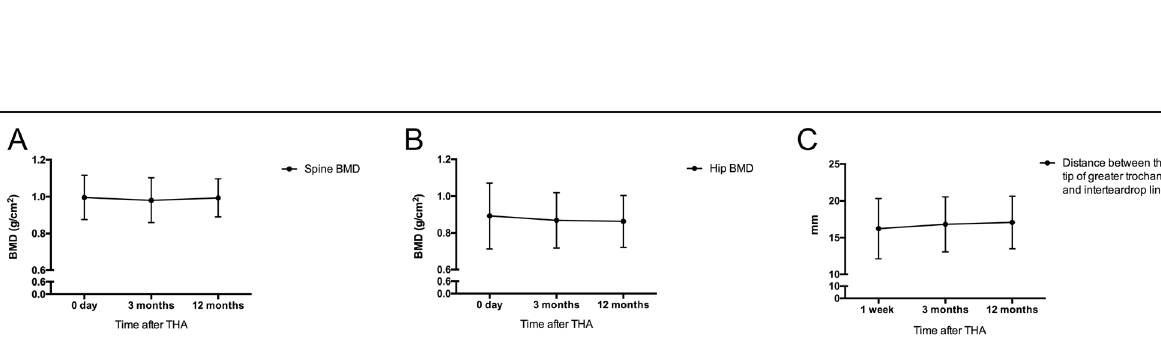
Fig. 3 Comparison of the spine ( a ) and hip BMD ( b ), and inferior displacement of the femoral stem ( c ) between the different time points during the follow-up